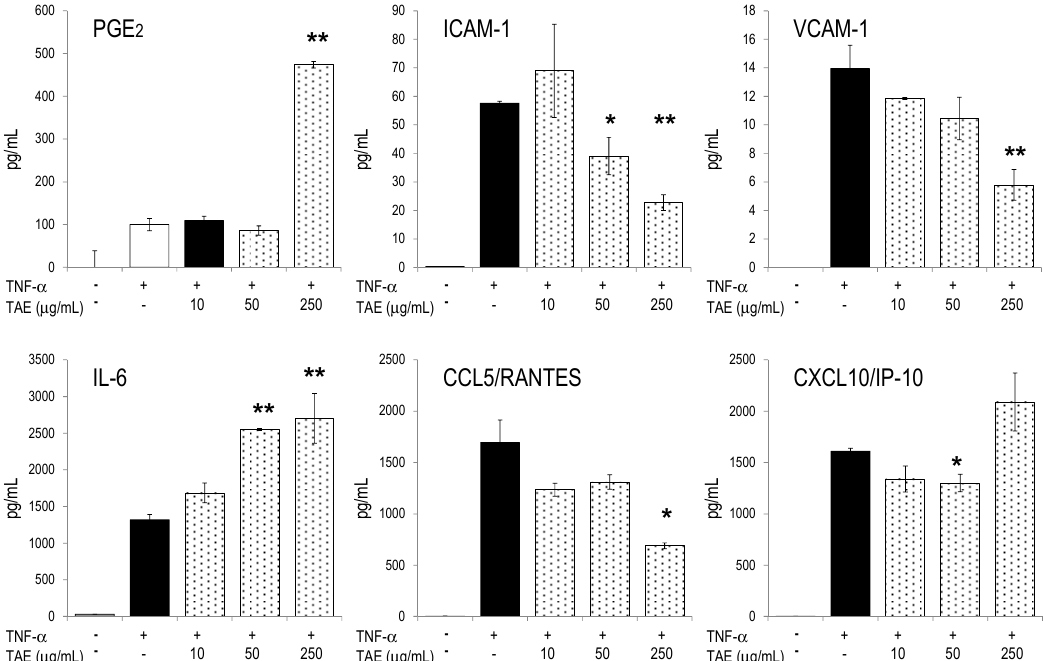
Figure 5. TAE influences HUVEC metabolites during endothelial dysfunction. HUVECs were incubated with TAE, activated with 10 ng/mL TNF- α and cultured for 24 h. Secreted cytokines, chemokines, ICAM-1 and VCAM-1 were quantified by Luminex technology (see Materials and Methods). Mean ± SD of duplicates are given. Unstimulated cells produced <10% of the mediators secreted by TNF- α stimulated cells. * p < 0.05, ** p < 0.01 ( vs. TNF- α -stimulated cells).